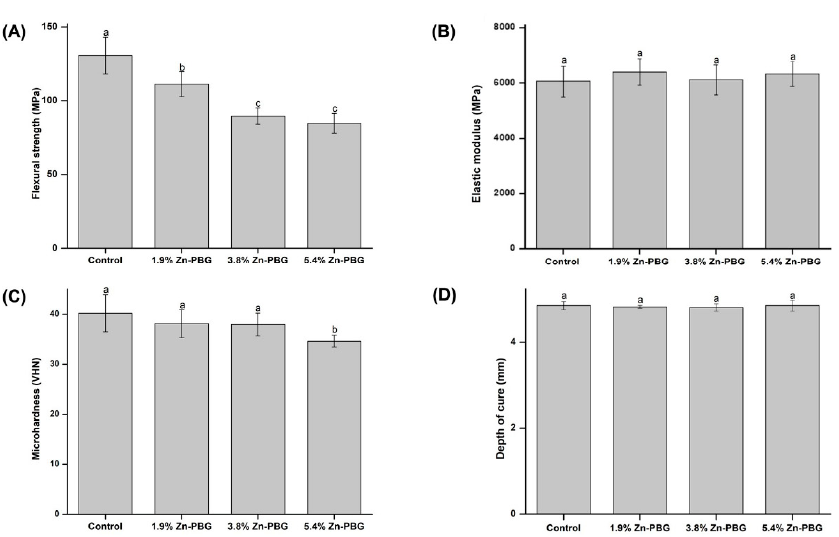
Figure 3. Comparison of flexural strength ( A ), elastic modulus ( B ), microhardness ( C ), and depth of cure ( D ) of samples. Letters indicate significant differences at p < 0.05.